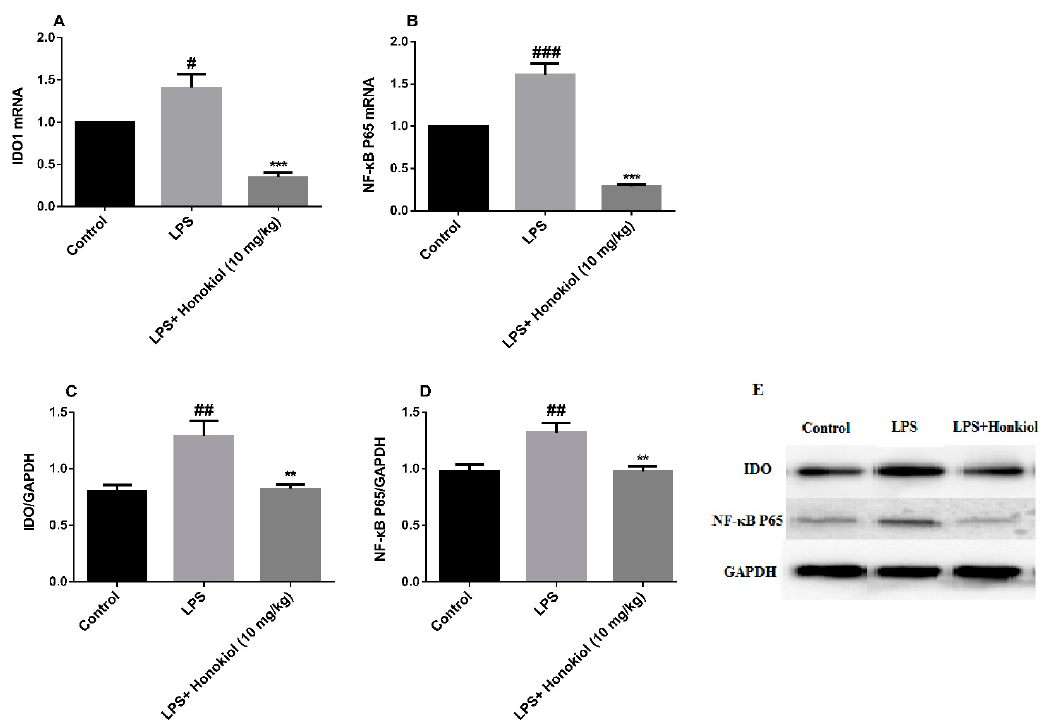
Figure 4. The effects of honokiol on mRNA and protein expression of hippocampal indoleamine 2,3-dioxygenase (IDO) and NF- κ B. ( A ) IDO1 mRNA expression; ( B ) NF- κ B mRNA expression; ( C ) IDO protein expression; ( D ) NF- κ B protein expression; ( E ) The western blot bands. Data are expressed as mean ± SEM ( n = 8). ### p < 0.001, ## p < 0.01, # p < 0.05 LPS vs. control; *** p < 0.001, ** p < 0.01 LPS + Honokiol vs. LPS.